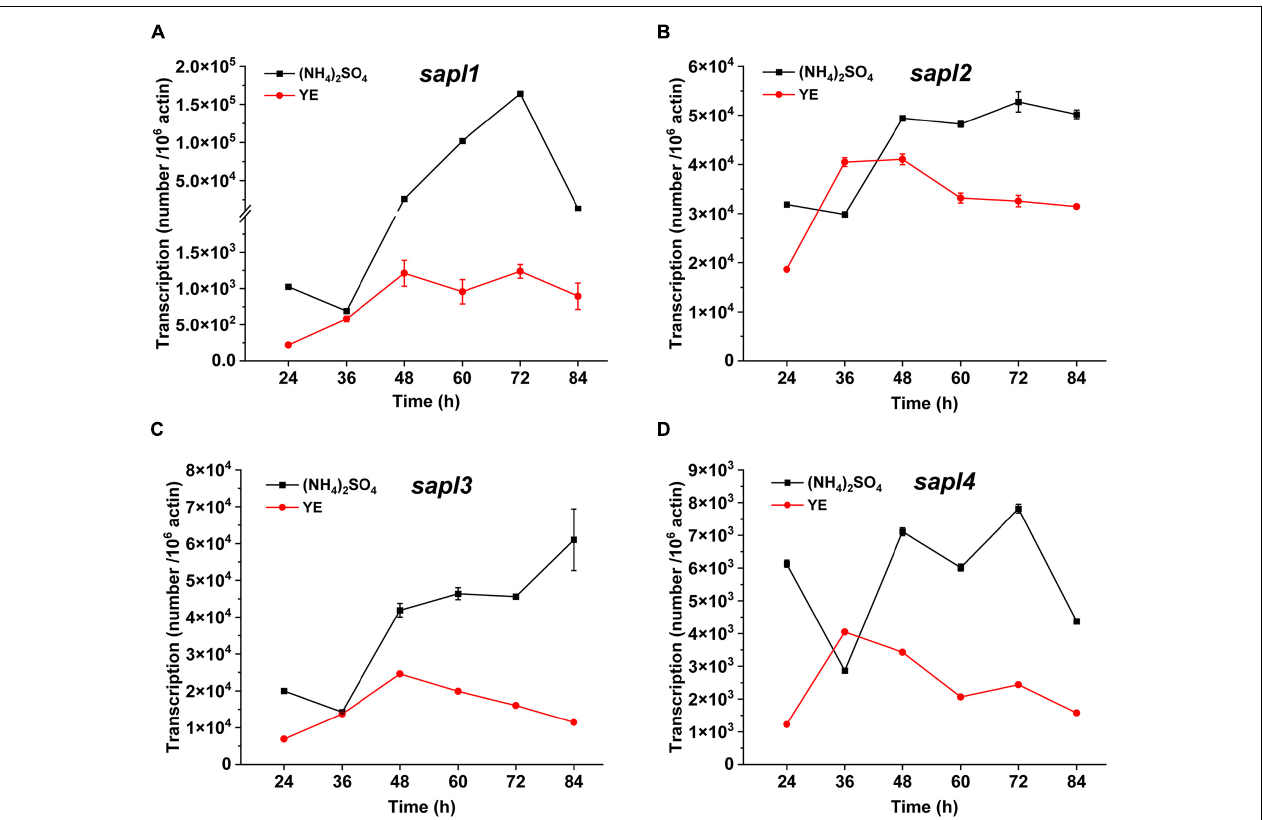
FIGURE 3 | The different transcriptional levels of sapl1 , sapl2 , sapl3 , and sapl4 genes cultured in fermentation medium with different nitrogen sources. Ammonium sulfate and yeast extract (YE). (A) The trend of sapl1 transcription level over time. (B) The trend of sapl2 transcription level over time. (C) The trend of sapl3 transcription level over time. (D) The trend of sapl4 transcription level over